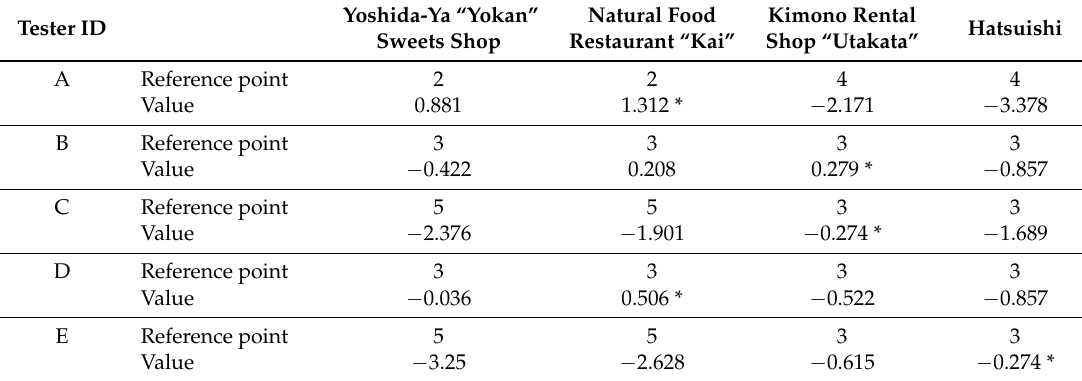
Table 13. Some personalized information values (some of them). * means the highest value.